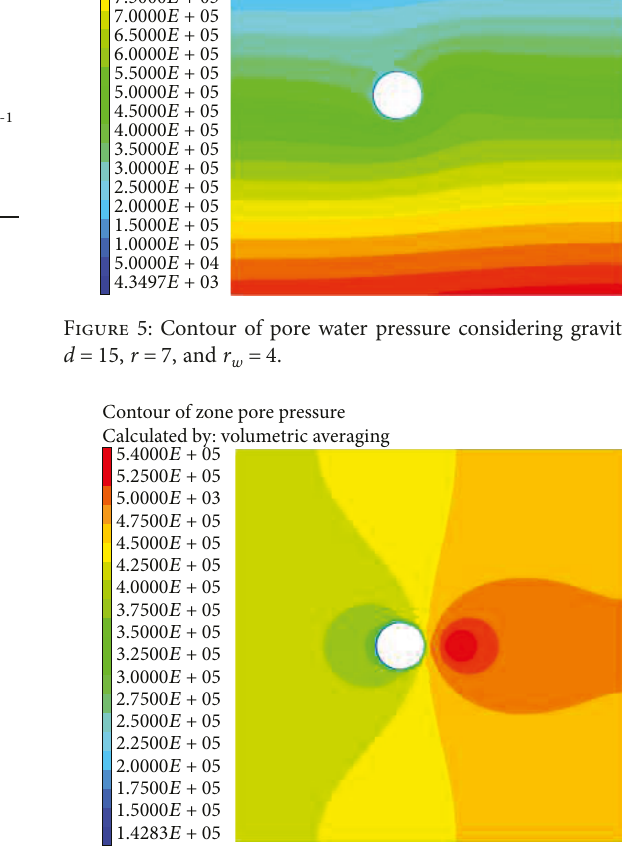
Figure 6: Contour of pore water pressure without considering gravity for d = 15 , r = 7 , and r w = 4